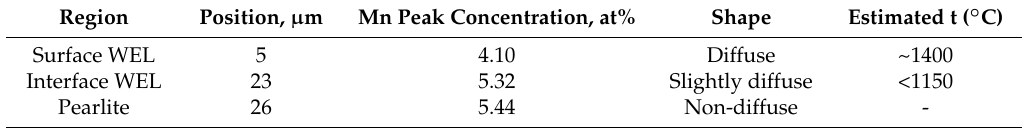
Table 1. Manganese concentration of needles at different depths in the WEL and in the pearlite matrix. Region Position, µ m Mn Peak Concentration, at% Shape Estimated t ( ◦ C) Surface WEL 5 4.10 Interface